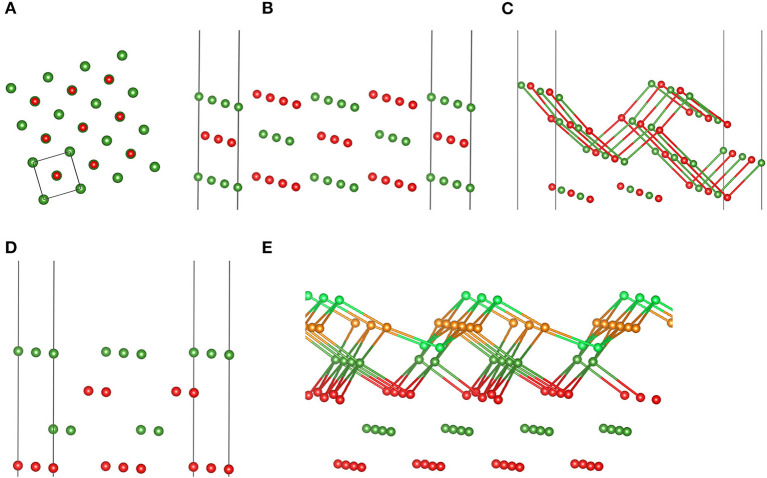
Structure models of the (001) surface in top view (A), the (110) (B) and facetted (110) surfaces (C) in perspective view, the Mg-terminated (111) surface in perspective view (D), as well as the (2 × 2) octopolar reconstructed (111) MgO surface (E) employed to assess MLFFs. (C,D) display bonds with a maximum length of 2.1 and 2.08 Å, respectively. Color code is the same as in Figure 1, except for Mg in light green and O atoms in orange to indicate optimized (001) facets (see also Watson et al., 1996, and Pojani et al., 1997).